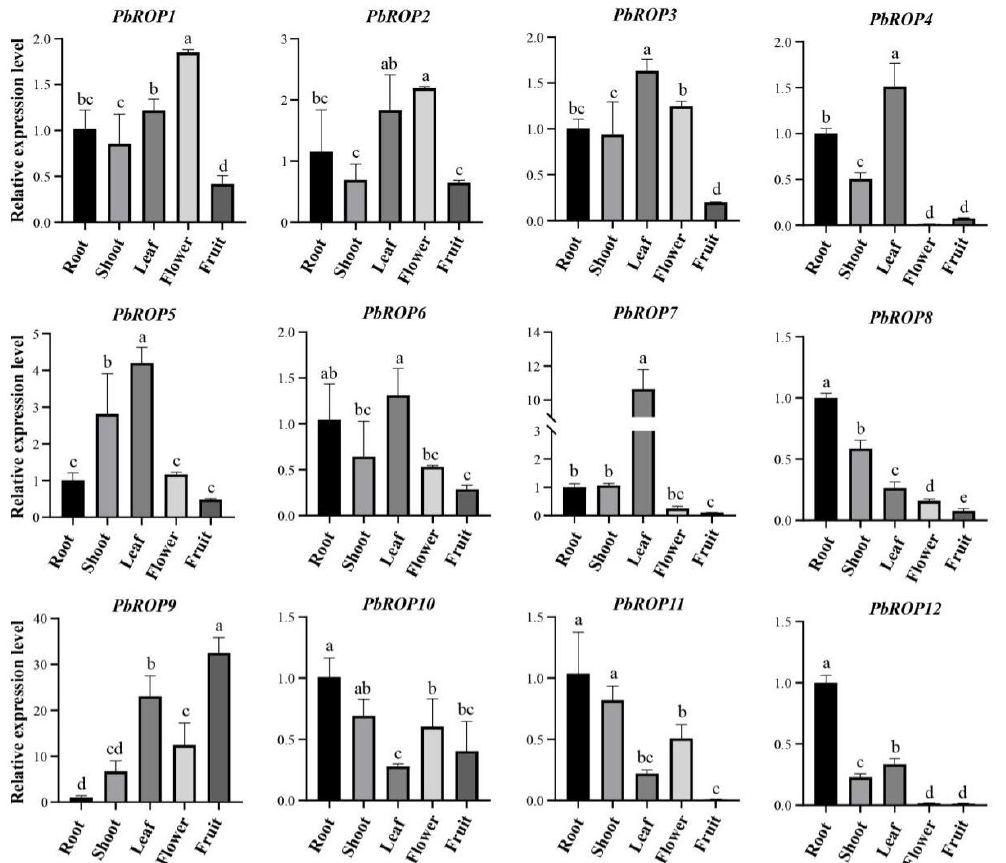
Figure 7. Expression profiles of PbROPs in different tissues of ‘ Duli ’ pear monitored by qRT-PCR. The expression levels of the 12 PbROPs in roots, shoots, leaves, flowers, and young fruits were measured by real-time RT-PCR. PbACTIN was used as the reference gene. The relative expression level of each gene was calculated relative to the transcript level of the roots (set as 1). Each bar represents the mean ± SE (n = 3). The chart was constructed using GraphPad Prism 8.0 software. Different letters on top of the columns indicate significant differences at p < 0.05 (n = 3) using Duncan’s multiple range test by the SPSS software.